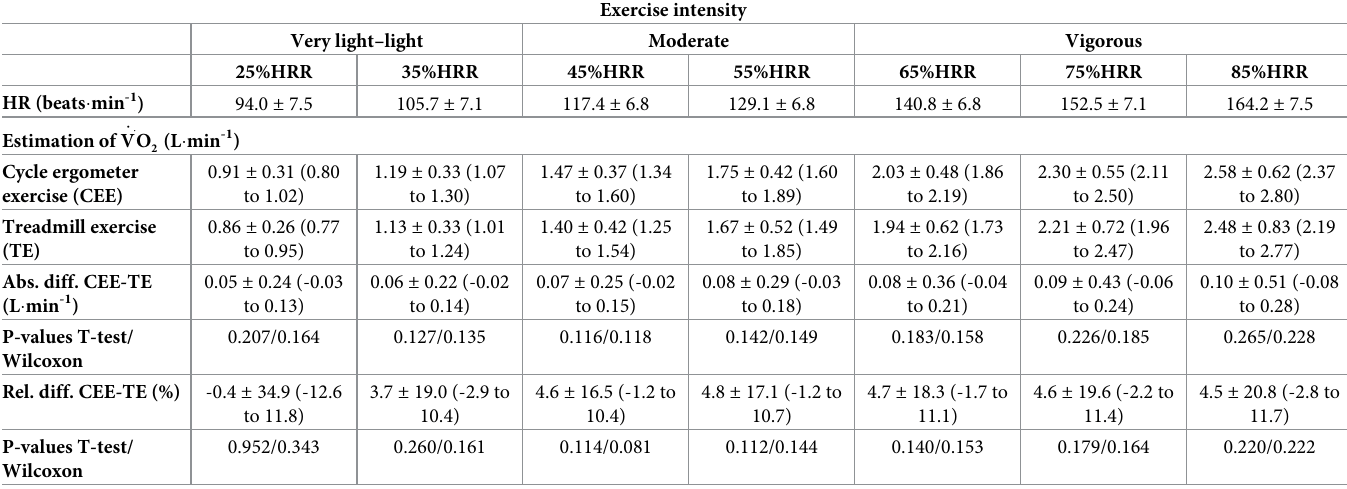
Table 6. Estimation of _ V _ O in model 1, and the absolute and relative exercise mode differences (n = 34, means ± SD, (95% CI) and 2